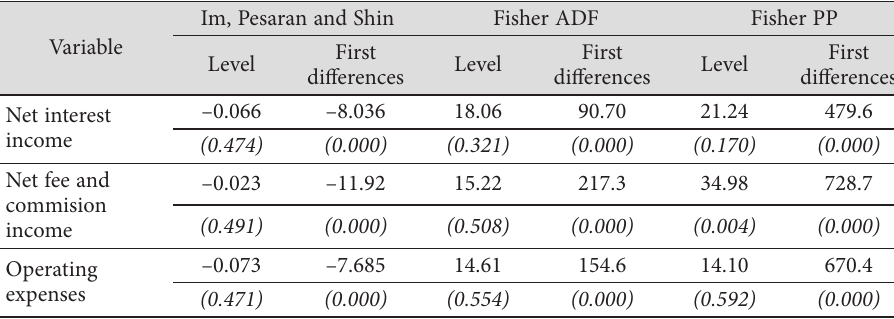
Table 1. Panel unit root tests (dependent variables)